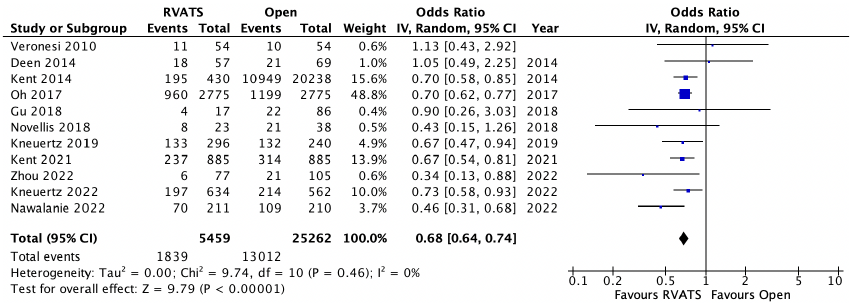
Figure 2. Mortality outcomes in patients who underwent robotic video-assisted thoracoscopic surgery compared with open thoracotomy for resectable non-small cell lung cancer [7–10,12–14,16– 18,20,22,23,26,27].